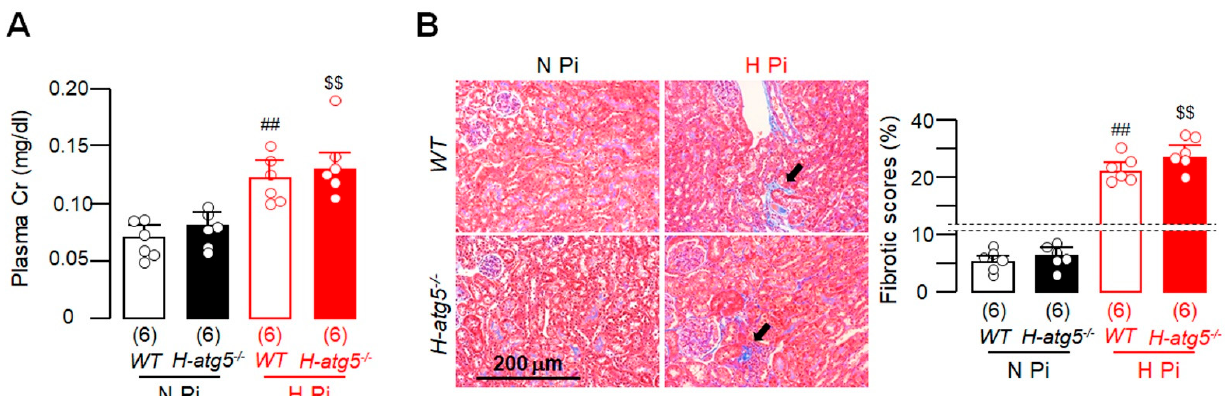
Figure 6. High phosphate induced similar severity of kidney fibrosis between WT and H-atg5 − / − mice. WT and H-atg5 − / − mice were fed with normal- or high-phosphate diet starting at 3 months old for 12 weeks. ( A ) Plasma creatinine (Cr). ( B ) Kidney fibrosis was determined in TC-stained sections. Left panel: Representative micrographs of TC-stained kidney sections. Black arrows depict tubulointerstitial fibrosis. Right panel: Semi-quantification of the TC-positive area over the kidney section with Image J. Sample number in each group is presented in brackets underneath corresponding bar. Quantitative data are presented as mean ± SD with scatter plots of individual data points. ## p < 0.01 vs. WT treated with normal-phosphate diet; $$ p < 0.01 vs. H-atg5 -/- mice treated with normal-phosphate diet. Statistical significance was assessed by two-way ANOVA followed by Newman–Keuls test. H Pi: high-phosphate diet; N Pi: normal-phosphate diet.